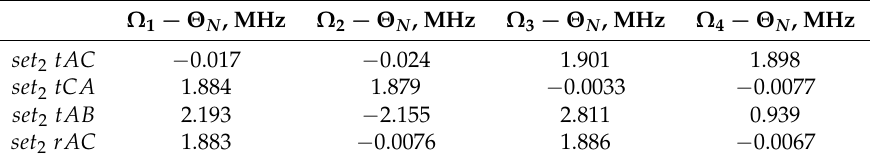
Table 1. Example sets for tuning the routing of the four-port